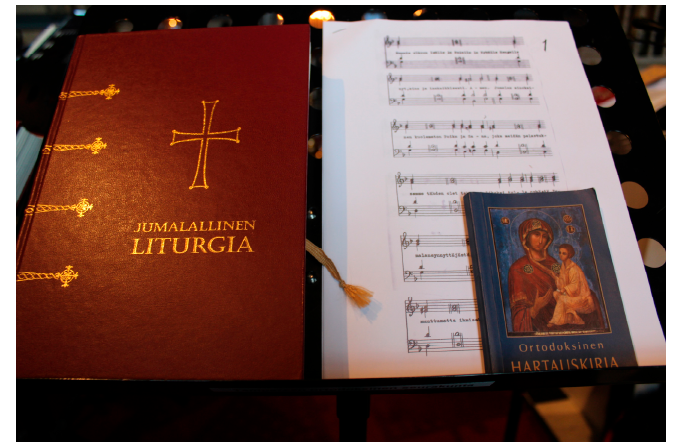
Figure 1. The Liturgy used by the choir during services. Photo by the author.